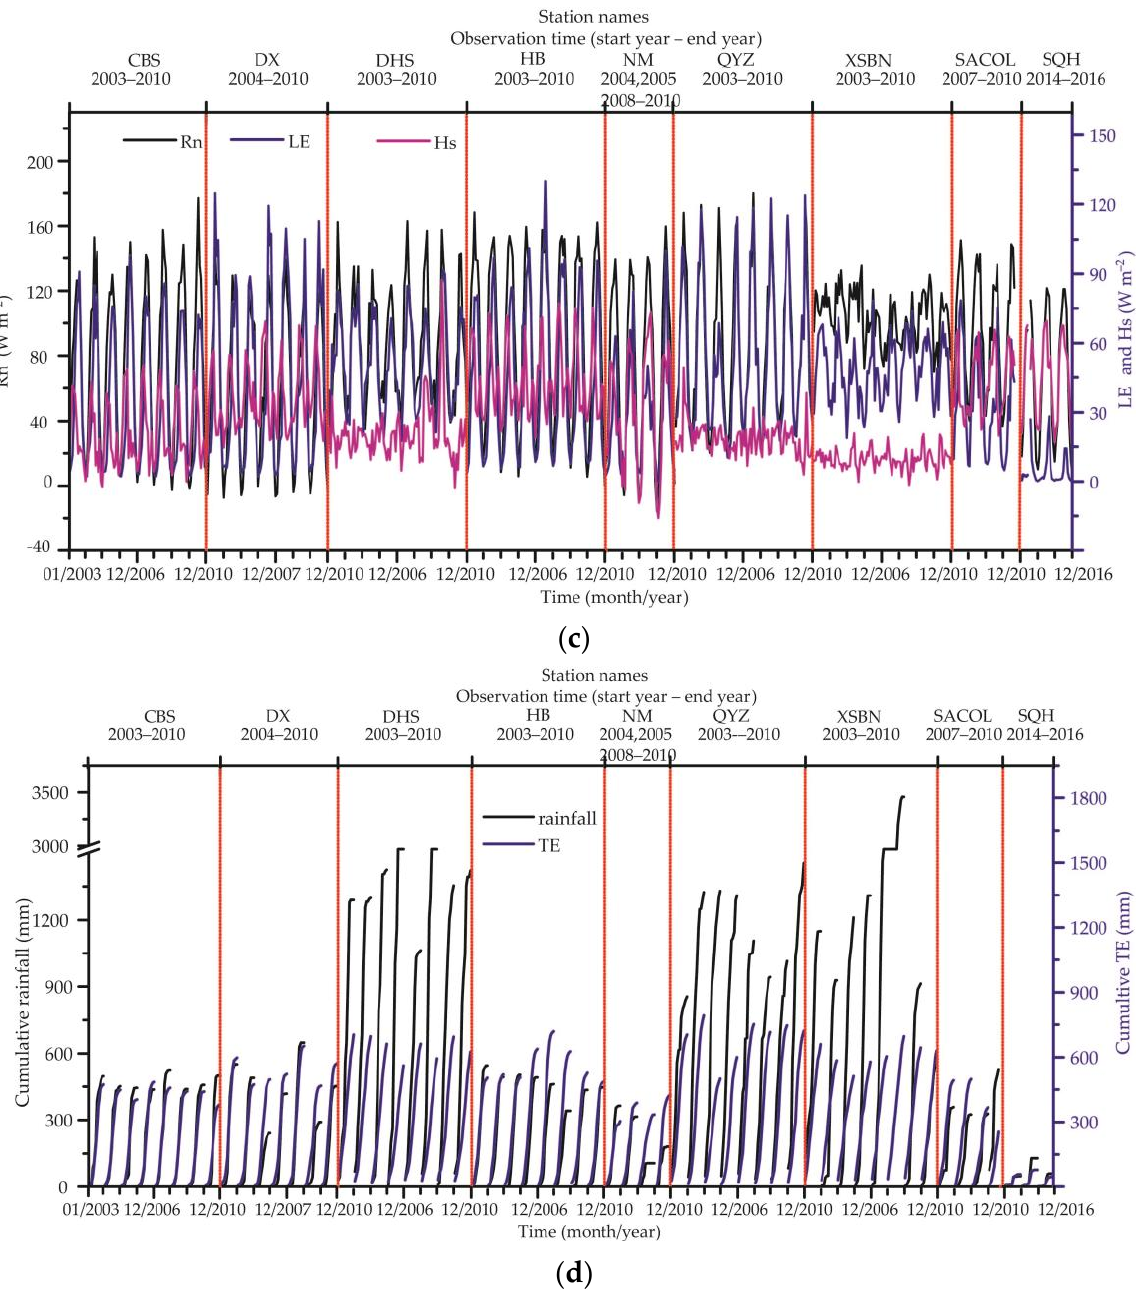
Figure 5. Time series of the different parameters in all observation sites in Table 2, in which the red dotted line distinguish the data between stations and in the lower abscissa, the interval between two scales is one year. Among them, ( a ) includes the monthly changes in Ta and rainfall; ( b ) includes the monthly changes in SWC and WVP; ( c ) includes the monthly changes in Rn, Hs, and LE; and ( d ) includes the monthly cumulative rainfall and TE calculated by Equation (1).